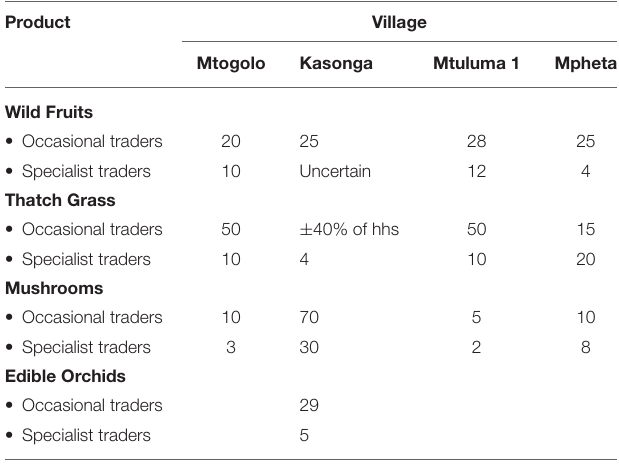
TABLE 6 | Estimated number of specialist and occasional traders of particular